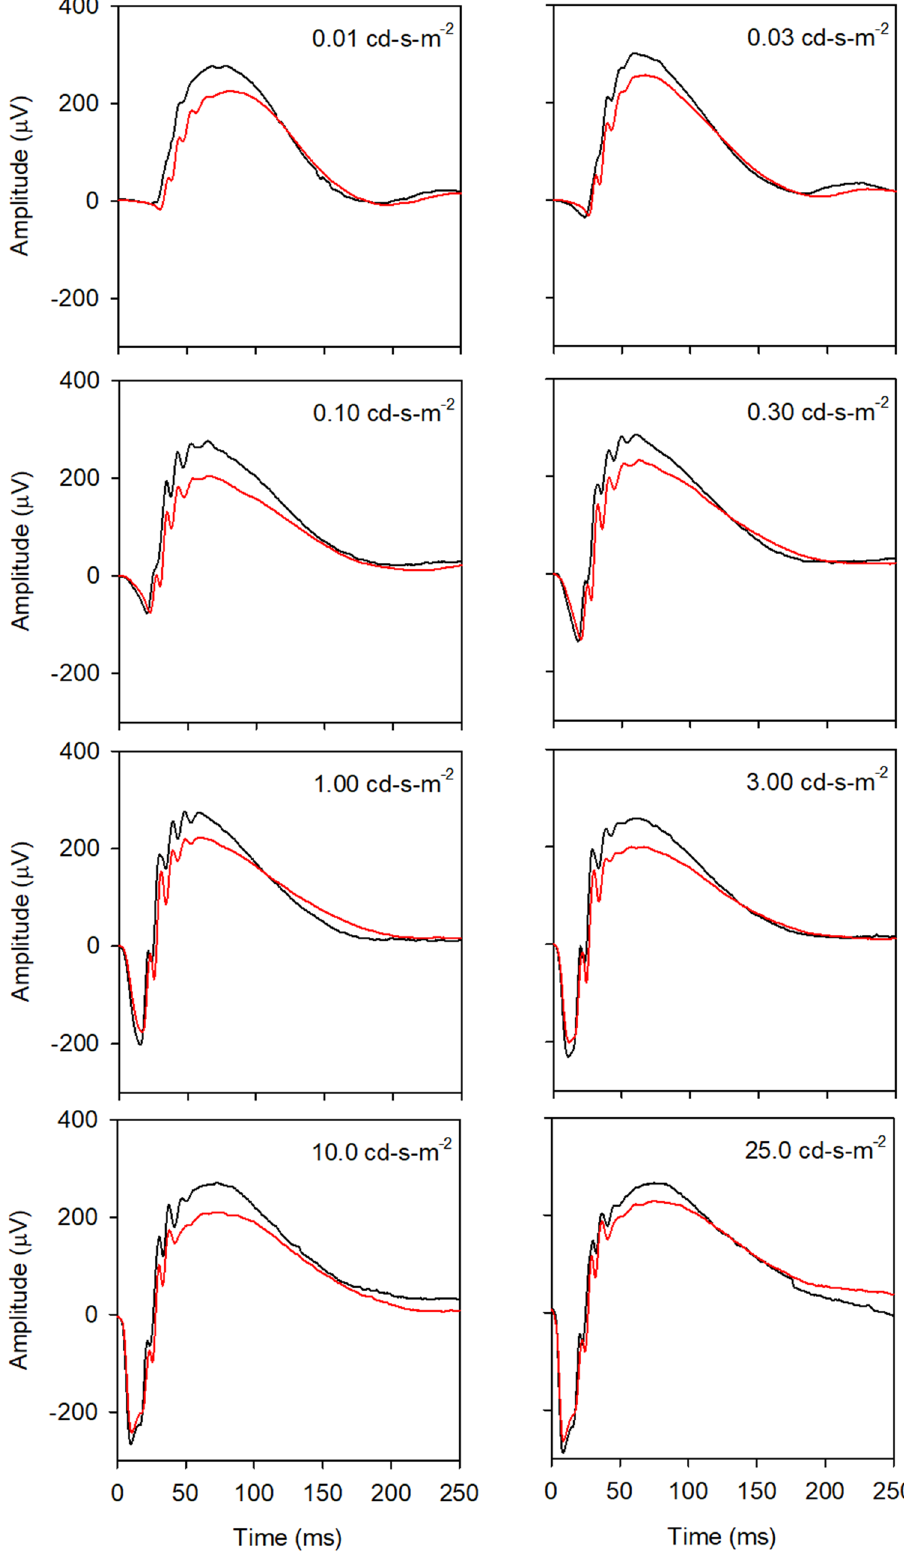
Figure 1. Mean waveforms for the WT (black) and 5xFAD (red) mice are shown for the 8 different flash luminances (indicated in each panel) under dark-adapted